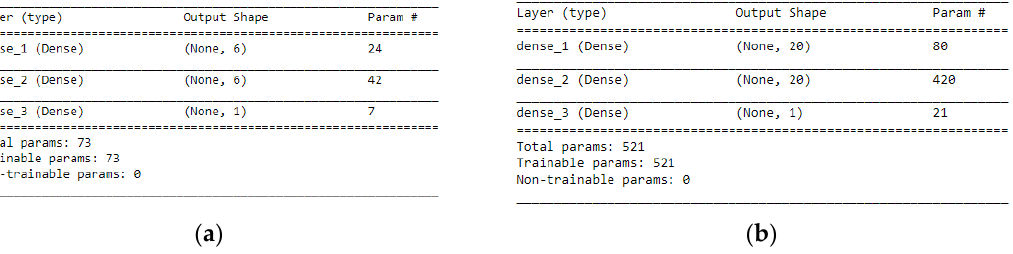
Figure 7. ( a ) The Architectural Structure of the ANN model (3-6-6-1); ( b ) The Architectural Structure of the ANN model (3-20-20-1). Figure 7. The flowchart of the Artificial Neural Network (ANN) model implementation. Figure 6. The flowchart of the Artificial Neural Network (ANN) model implementation.